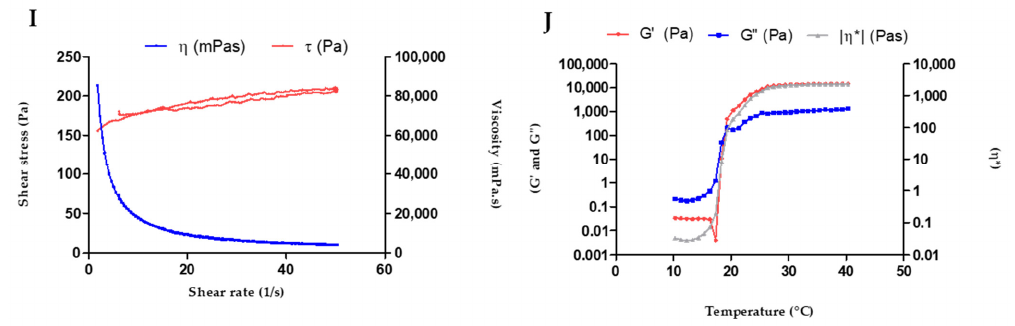
Figure 2. Flow and viscosity curves of samples: ( A ) CSP-O1 at 4 °C; ( B ) CSP-O1 at 25 °C; ( C ) CSP-O1 at 37 °C; ( D ) CSP-O2 at 4 °C; ( E ) CSP-O2 at 25 °C; ( F ) CSP-O2 at 37 °C; ( G ) CSP-O3 at 4 °C; ( H ) CSP-O3 at 25 °C; ( I ) CSP-O3 at 37 °C; and ( J ) SOL-GEL temperature transition of CSP-O3 hydrogel.